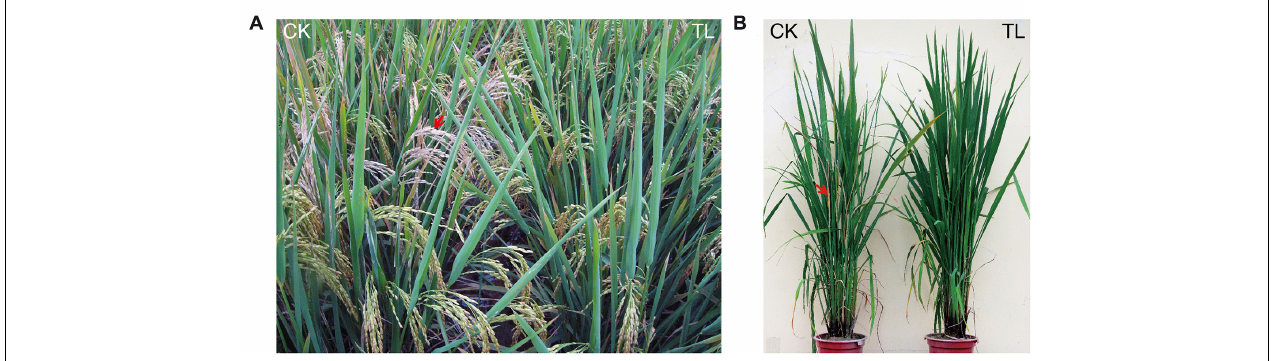
FIGURE 4 | Insect resistance performance of transgenic rice in the field. (A) Resistance of transgenic homozygous lines against rice leaf folder and rice stem borer. CK: MH86, TL: transgenic line. Red arrow indicates white head. (B) Resistance of transgenic hybrids against rice stem borer. CK: II Youming86, TL: transgenic hybrid. Red arrow indicates dead hearts.